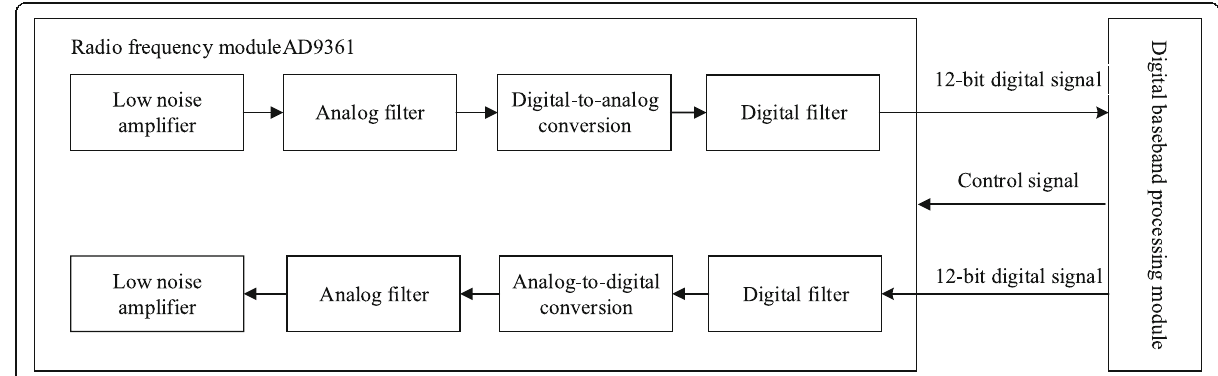
Fig. 1 The structure of the software radio system. The software radio system is mainly composed of an RF module and a digital baseband processing module